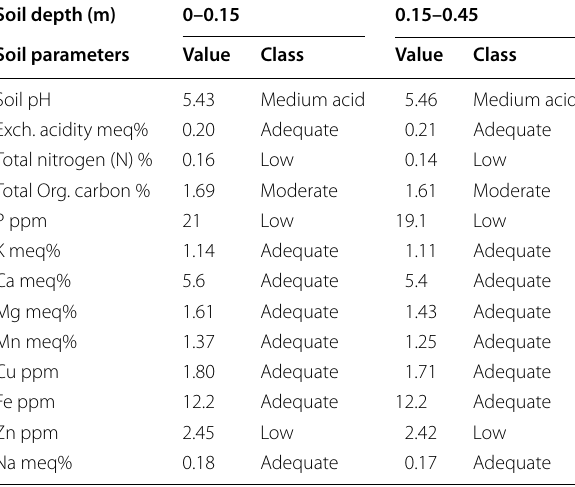
Table. 3 Physical properties of the experimental soils Depth (m) Soil texture